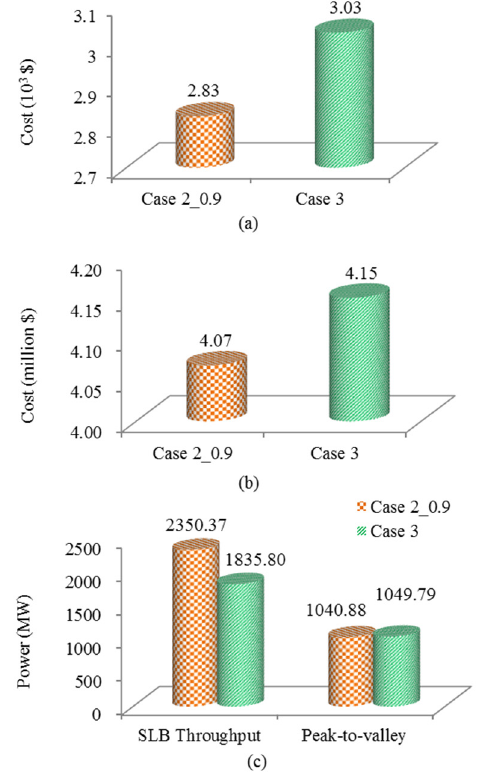
Figure 14. Results comparison of Case 3 and Case 2 with 0.9 confidence degree. ( a ) is the thermal generating cost comparison; ( b ) is the system operation cost comparison and ( c ) is the SLB throughput and peak ‐ to ‐ valley comparison.